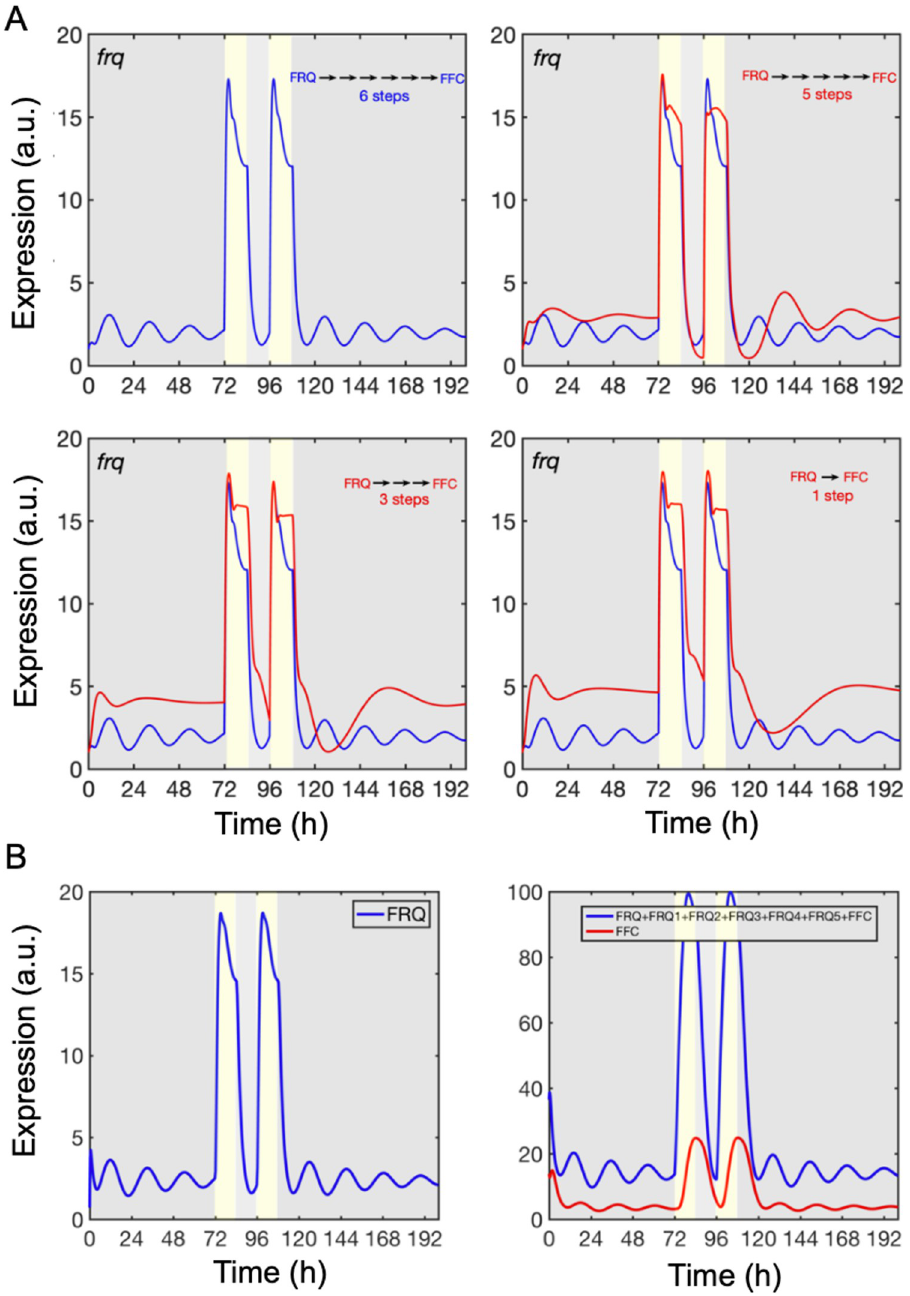
Fig 4. Maturation of inactive FRQ to active FFC is crucial for circadian rhythmicity. (A) Maturation of FRQ to FFC was modelled by a linear chain of 6 generic steps. The impact of the number of steps on frq expression levels and rhythm is shown. (B) Delay between newly synthesized FRQ and assembled FRH (left panel) and abundance of all unassembled FRQ-species versus assembled FRH (right panel).